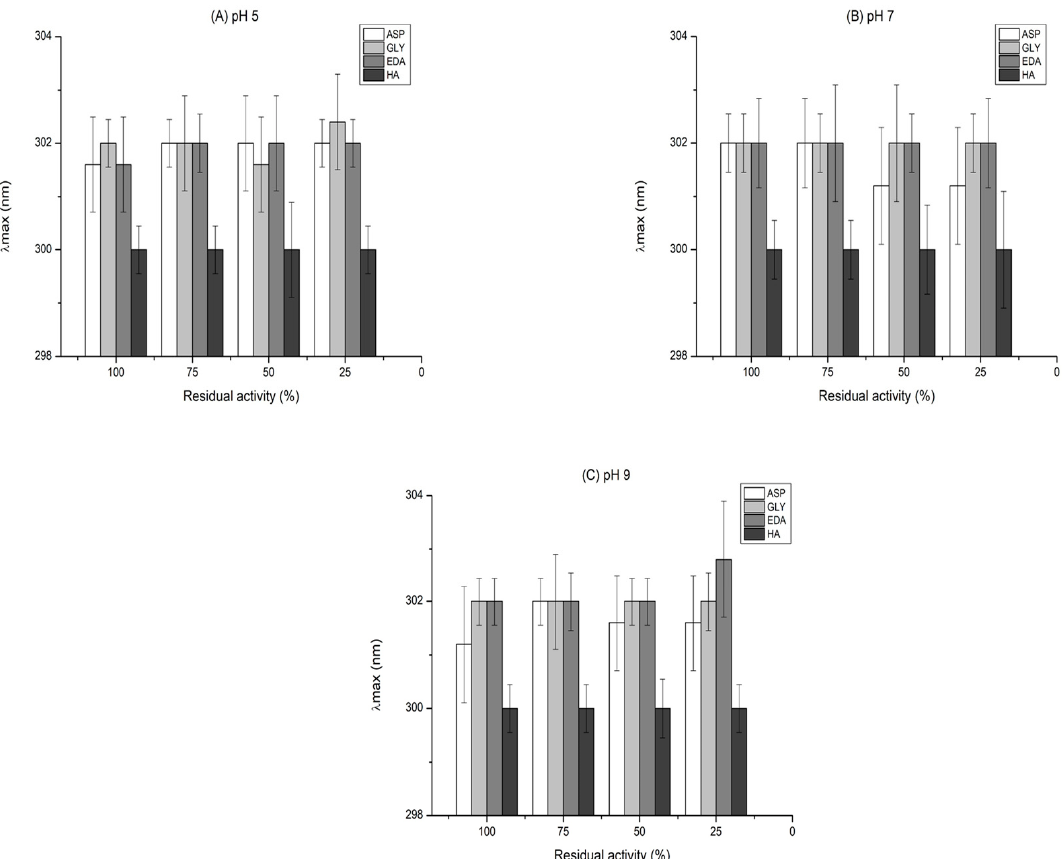
Figure 9. Intrinsic fluorescence ( λ max) of immobilized CALB biocatalyst blocked with different reagents and inactivated at different pH values pH 5 ( A ), pH 7 ( B ), and pH 9 ( C ). From the intrinsic fluorescence spectra, ( λ max) were plotted for the different CALB at different inactivation degrees. The residual activity means the activity exhibited by the CALB after being incubated at a certain time at different pH. The residual activity at 100% indicates that they are fully active biocatalysts.